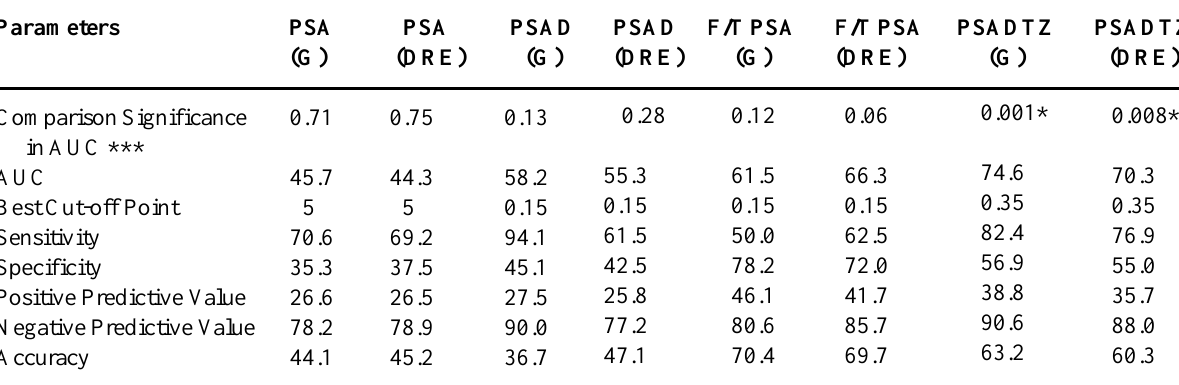
Table 4 – Analytical and descriptive results from performance measures of parameters in the general (G) and negative digital rectal examination (DRE) groups.